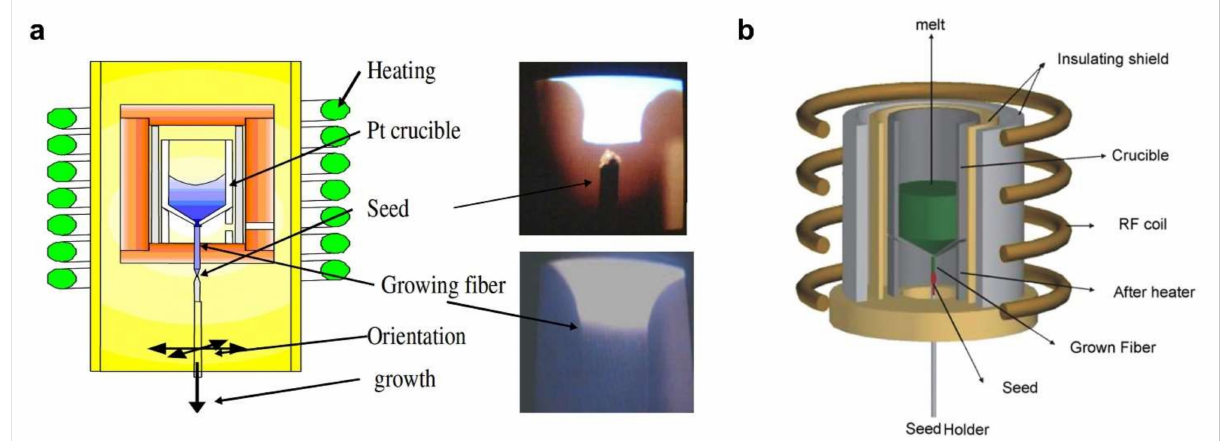
Figure 6. Schematic and photographs of micro pulling down set-up. ( a , b ) BGO and YAlO3 crys- tal fibers grown by micro pulling down technique. Reprinted with permission from ref. [91,99]. Copyright 2009 and 2007, Elsevier